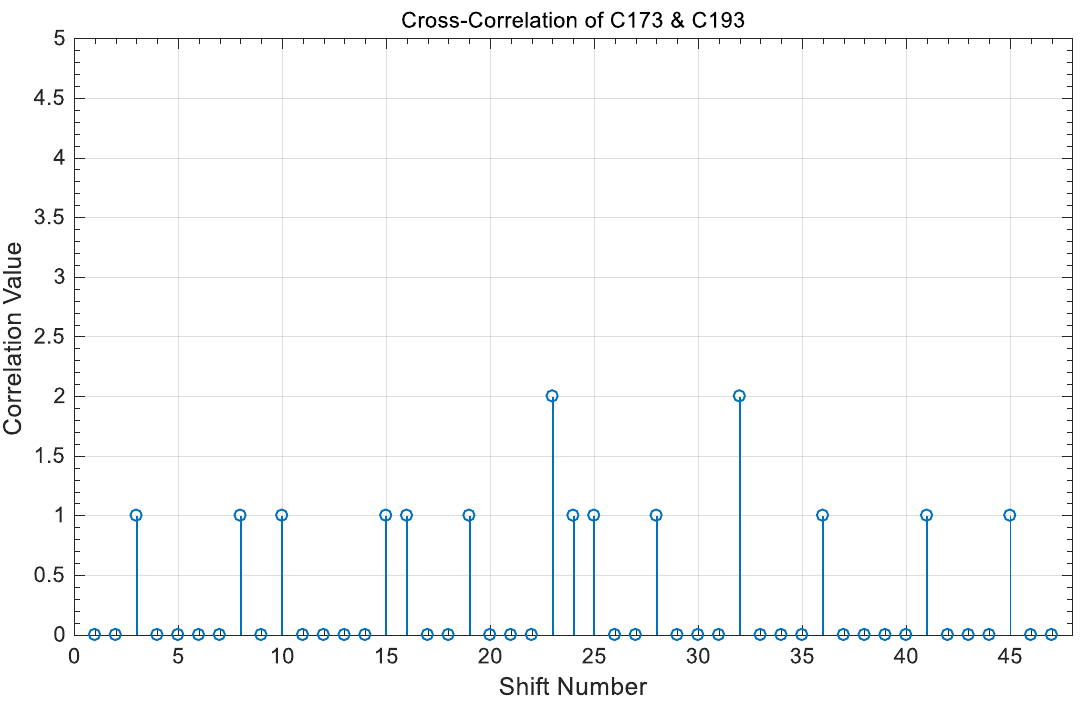
Figure 19. Cross-correlation between 𝐶 173 and 𝐶 193 sequences from different groups, 𝑃 1 = 5 and 𝑃 2 = 7 .